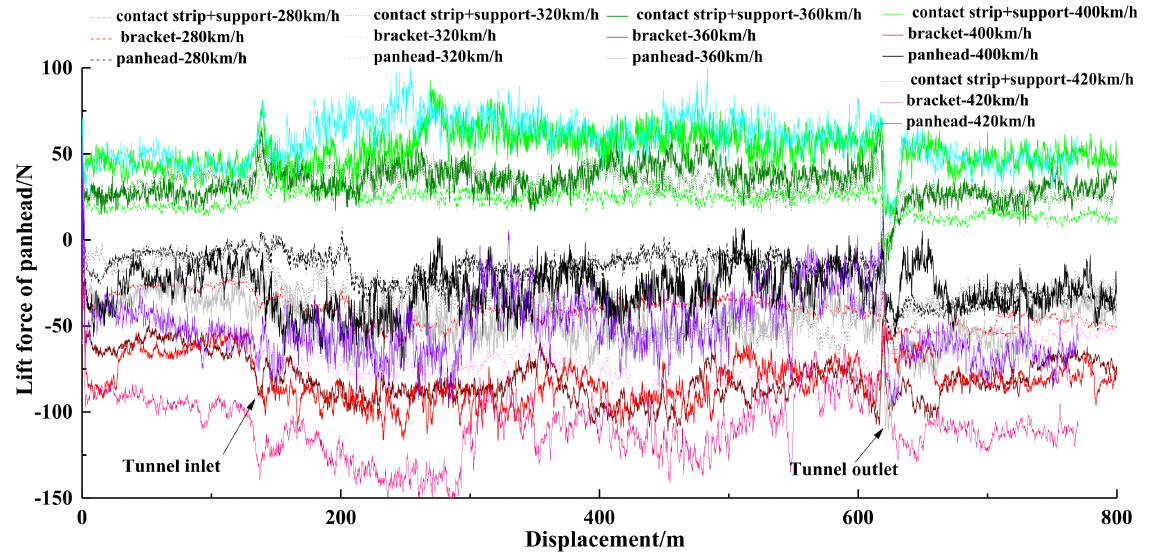
Figure 11. Comparison curves of panhead aerodynamic lift passing through tunnel at different speeds.